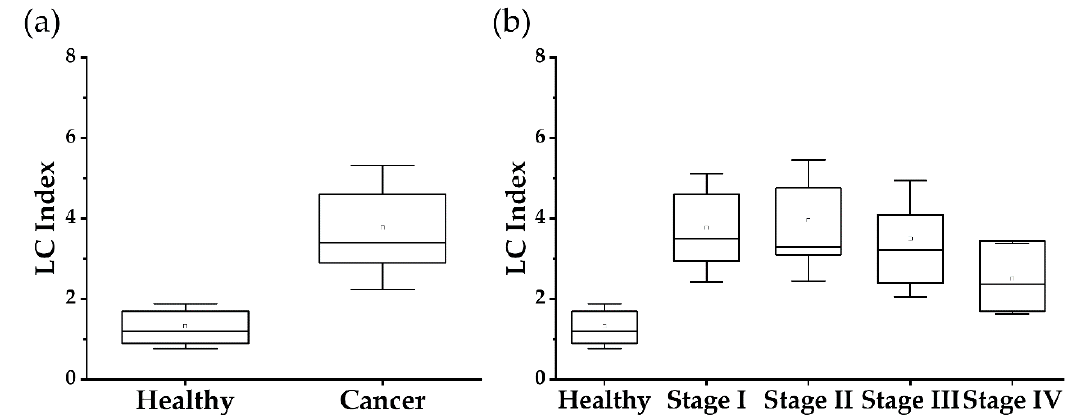
Figure 2. Application of LC index in ( a ) Discrimination of healthy control ( n = 359) and all stage lung cancer patients ( n = 244) ( b ) Discrimination of healthy control ( n = 359) and stage I ( n = 160), stage II ( n = 32), stage III ( n = 49), stage IV ( n = 3) lung cancer patients.